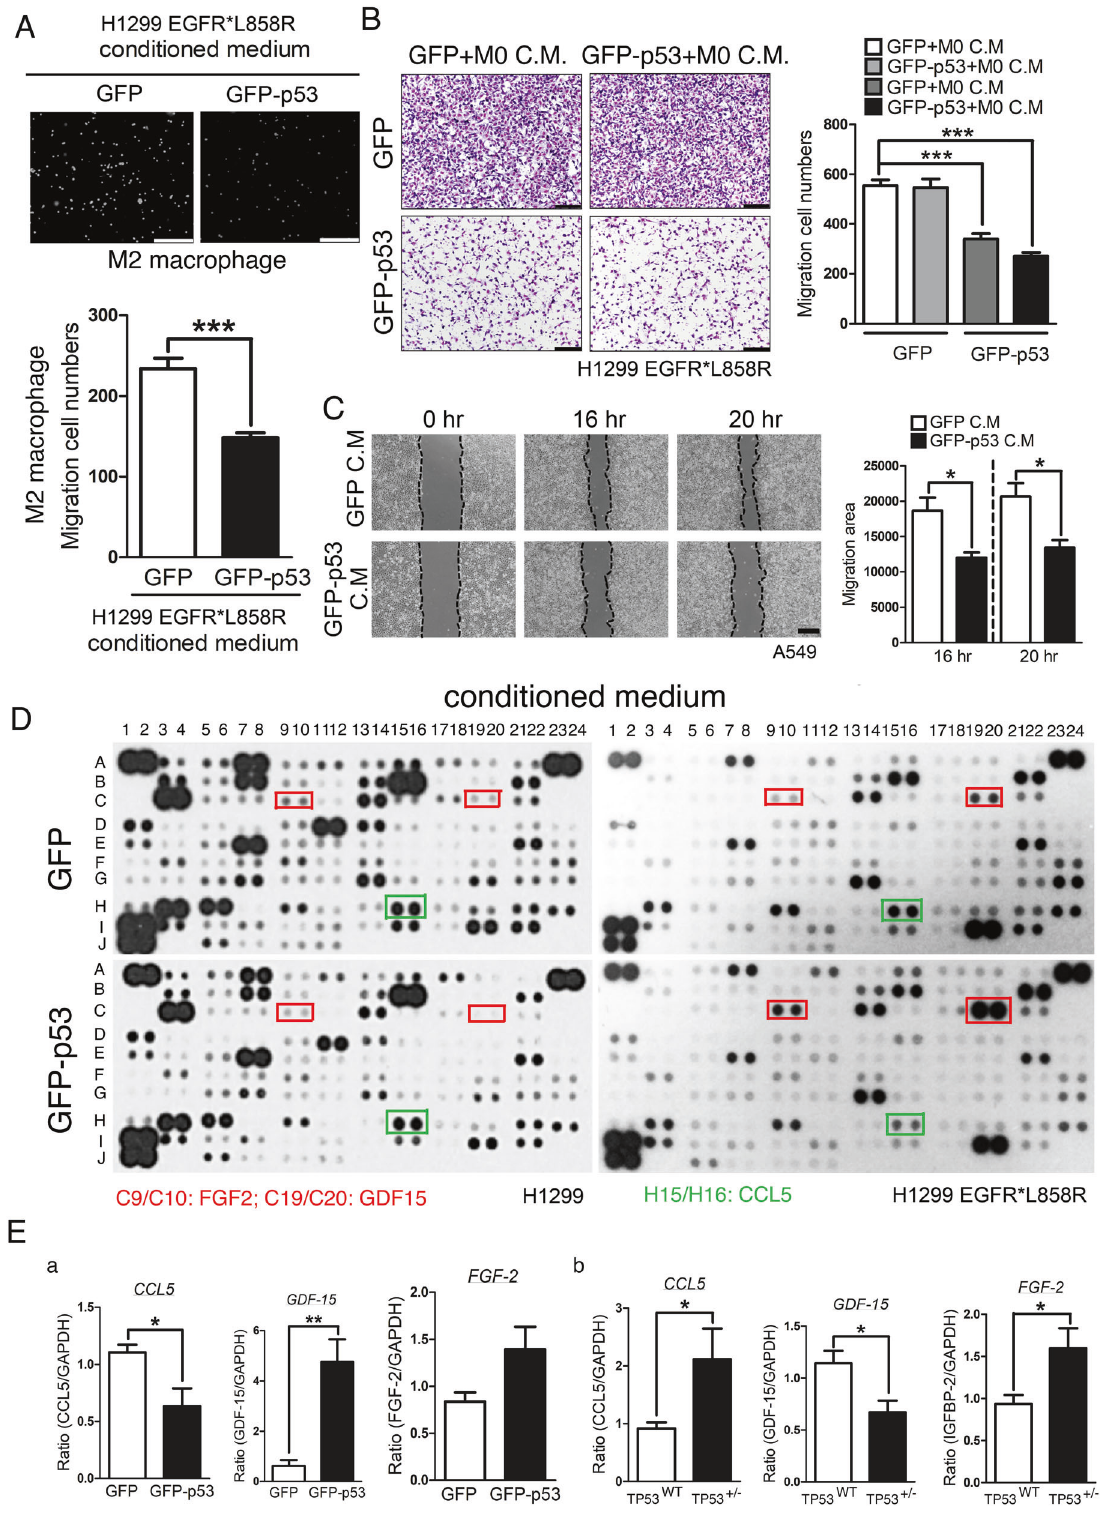
Fig. 5 The p53-mediated changes in conditioned medium are involved in the migration abilities of macrophages and lung cancer cells. The M2 macrophages ( A ), H1299 L858R cells ( B ), and A549 cells ( C ) were treated with conditioned medium collected from H1299 L858R cancer cells with or without GFP-p53 overexpression; cell migration was studied by the chamber assay and wound healing assay. The conditioned medium collected from H1299 cells ( D , left panel) and H1299 L858R cells ( D , right panel) lung cancer cells with or without GFP-p53 overexpression were used to examine the protein repertoire by a protein array ( D ). The mRNA levels of CCL5, GDF15, and FGF2 in H1299 L858R cells with or without GFP-p53 overexpression ( E , a ) and in mice with EGFR L858R -induced lung cancer with or without TP53 knockout ( E , b ) were studied by q-PCR. After three independent experiments were completed, the statistical assay was performed by t tests; * P < 0.05, ** P < 0.01, *** P <